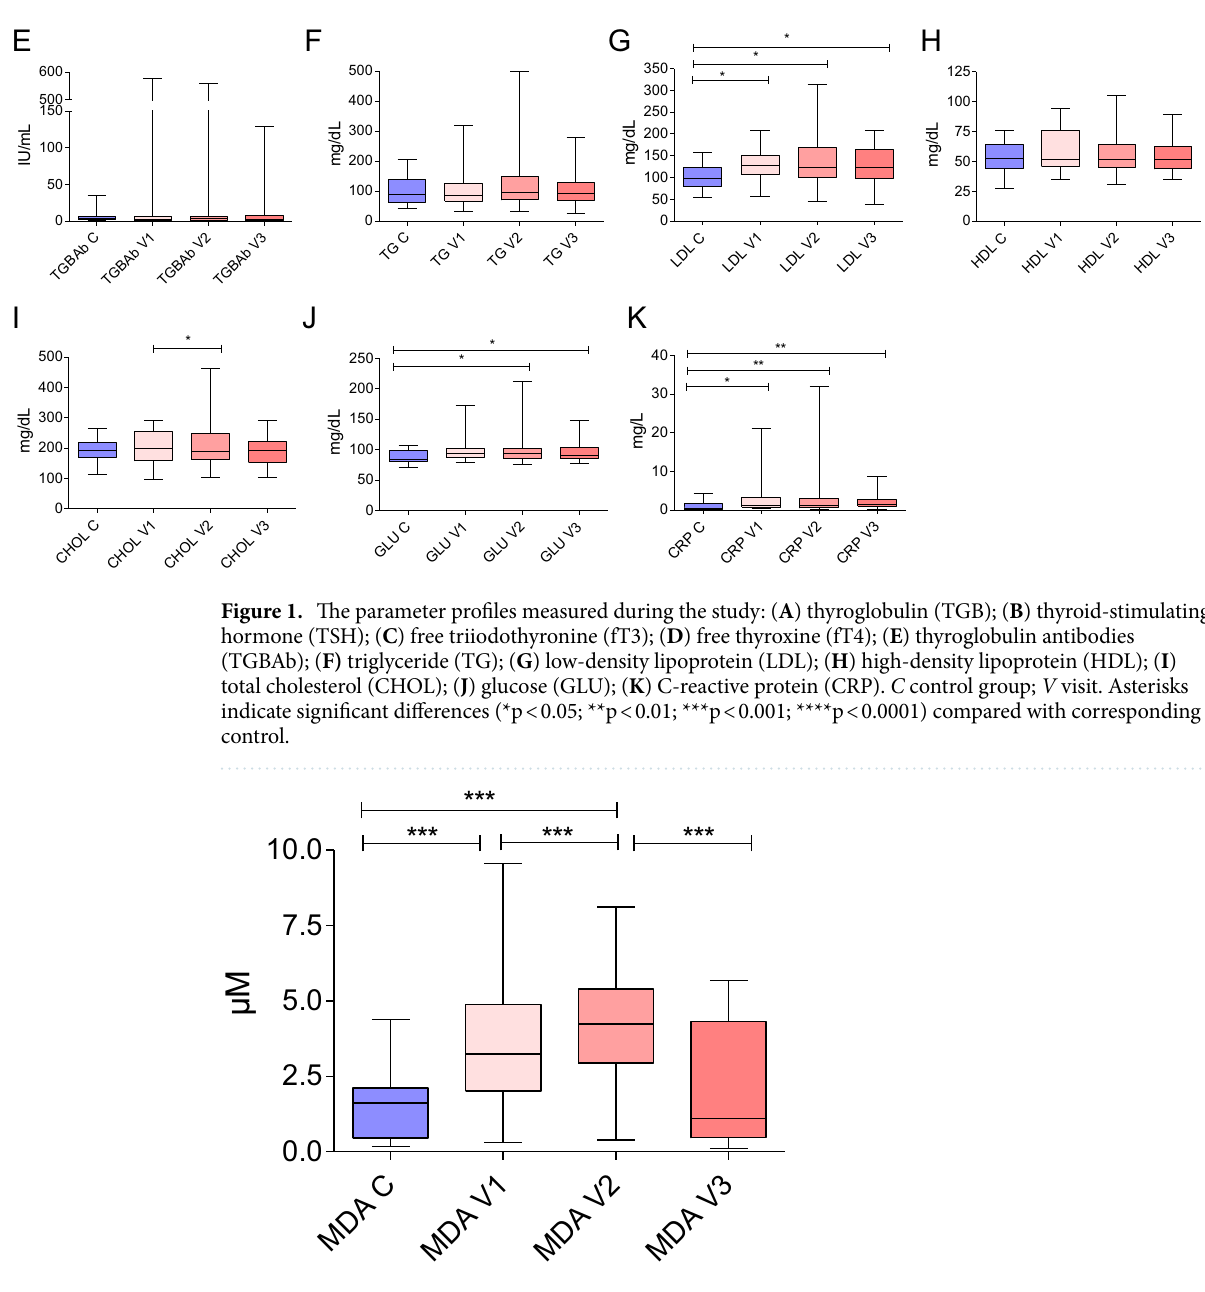
Figure 2. MDA concentrations in the DTC patients among the ablation treatments. *** p < 0.001; C control group; MDA malondialdehyde; v